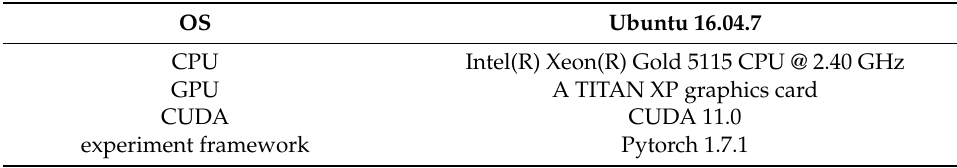
Table 2. Experimental